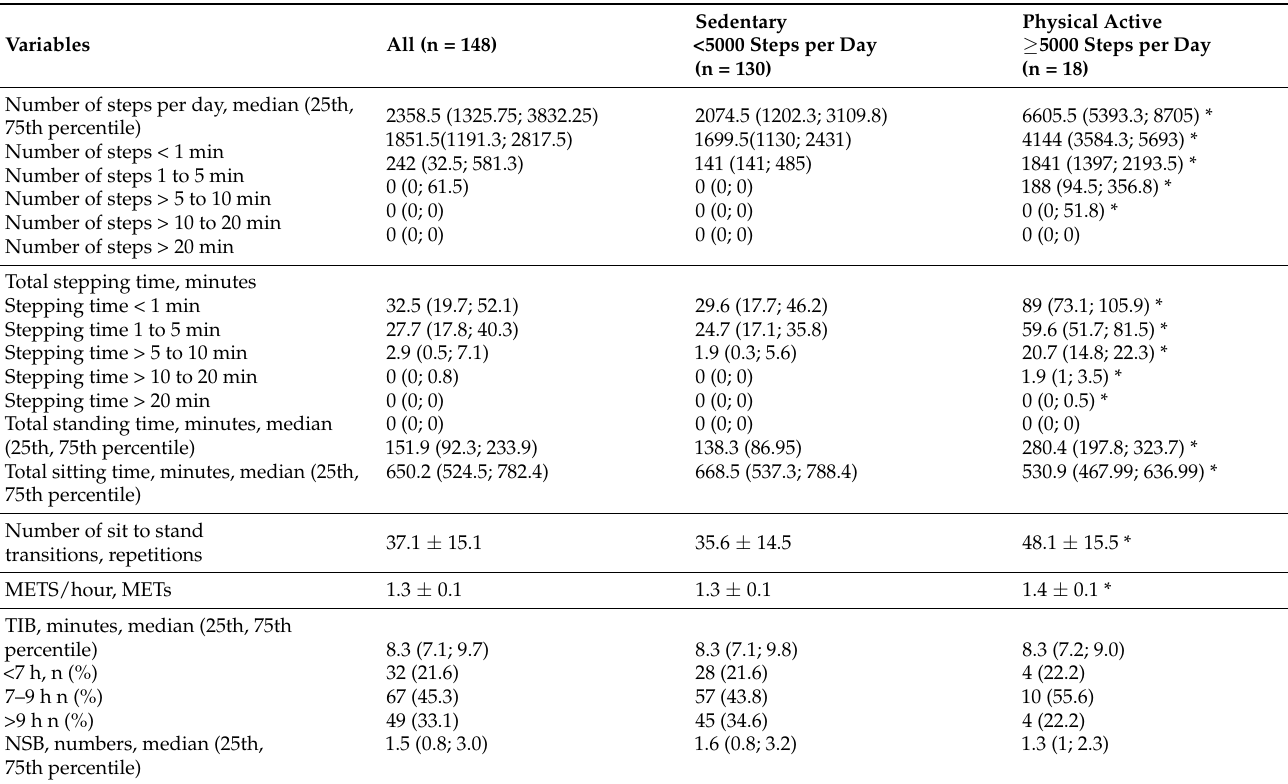
Table 2. Characteristics of physical activity and sleep